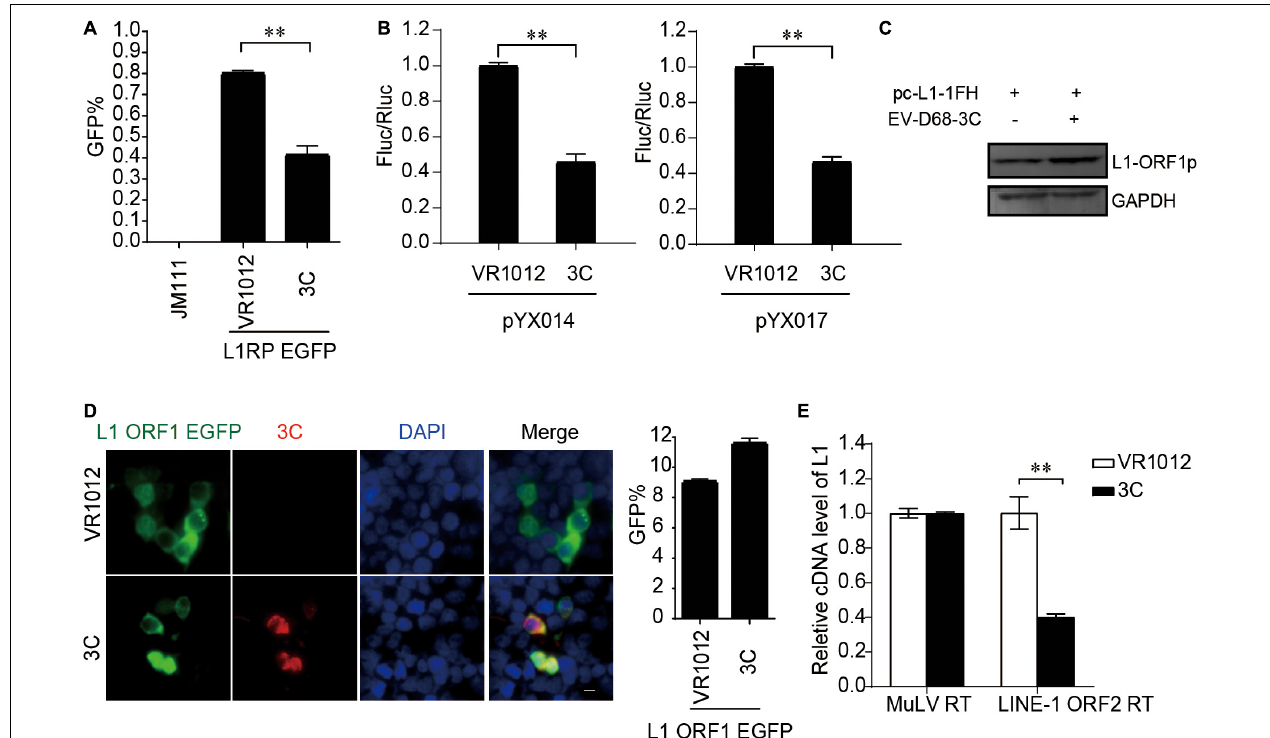
FIGURE 5 | Suppression of LINE-1 retrotransposition by EV-D68 3C. (A) L1RP EGFP plasmids and VR1012/VR1012-3C plasmids were transfected into HEK 293T cells. JM111 was used as a negative control. Flow cytometry was performed 96 h post-transfection. The bar graph depicts the M ± SD of each experiment, performed in triplicate The asterisks indicate statistically significant differences between groups by Unpaired Student’s t -test ( p < 0.01). (B) HEK 293T cells were transfected with pYX014 or pYX017 constructs together with VR1012 or VR1012-3C-. Then dual-luciferase assay was performed 4 days post-transfection. The VR1012 transfected sample was set to 1.0. The asterisks indicate statistically significant differences between groups by Unpaired Student’s t -test ( p < 0.01). (C) VR1012 or VR1012-3C plasmids were co-transfected with pc-L1-1FH. Western blot was performed after 48 h. (D) pEGFP-N1-ORF1-EGFP and VR1012/VR1012-3C plasmids were co-transfected. Immunostaining and fluorescence imaging were performed as described in the “Materials and Methods” 48 h post-transfection: scale bar, 20 µ m. Bar graph represents the percentage of GFP-positive cells from flowcytometry. The asterisks indicate statistically significant differences between groups by Unpaired Student’s t -test ( p < 0.01). (E) LEAP assay and quantitative real-time PCR were performed as described in the “Materials and Methods.” The bar graph of relative cDNA level of L1 represents reverse transcription efficiency of L1 ORF2p or MuLV. The relative cDNA level of MuLV RT was set to 1.0. The asterisks indicate statistically significant differences between groups by Unpaired Student’s t -test ( p <